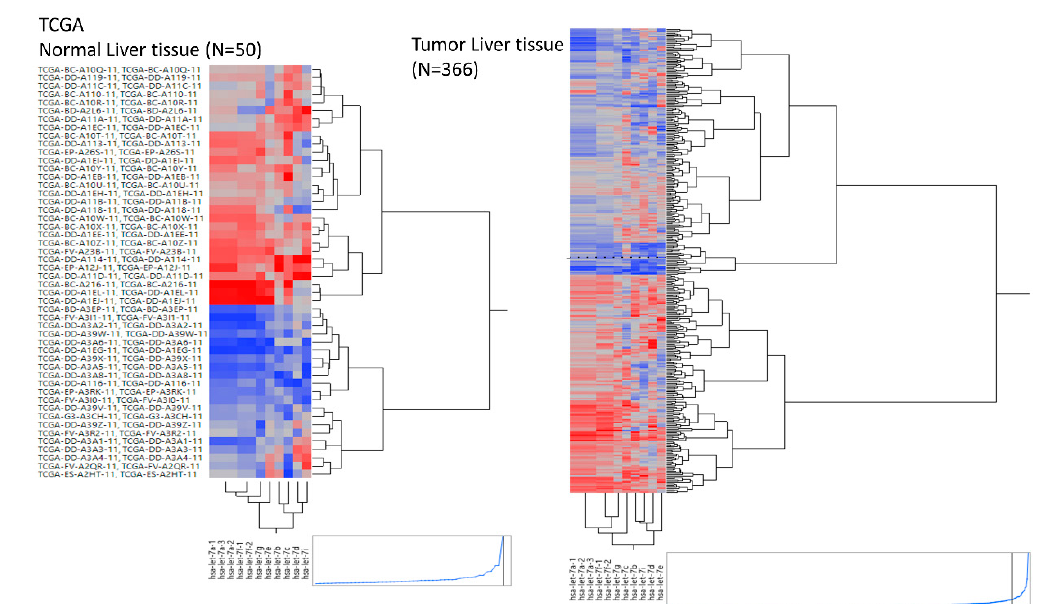
Figure 2. Hierarchical clustering plot (heatmap) of the let-7 miRNA family expression in healthy ( n = 50) and tumor ( n = 366) liver tissue samples obtained from TCGA-LIHC.